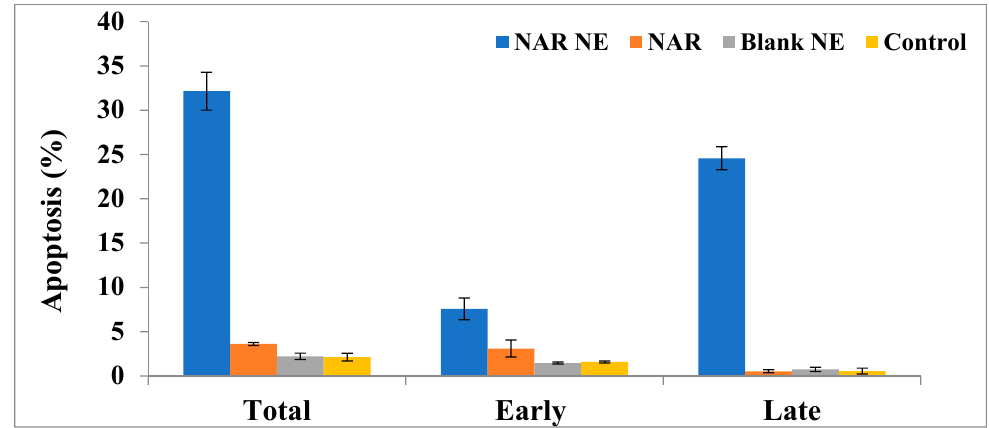
Figure 12. Effect of the IC 50 concentrations on free NAR, blank NE, and NAR-NE (compared with no treatment) in inducing total, early, and late apoptosis in A549 cells ( p < 0.05 for free NAR vs. NAR-NE).